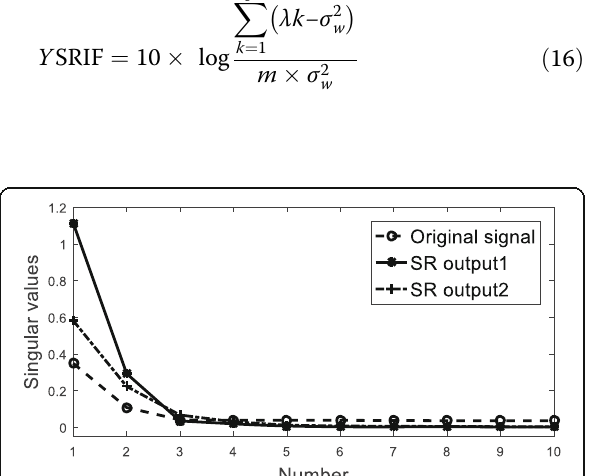
Fig. 4 Comparison of signal singular values before and after stochastic resonance